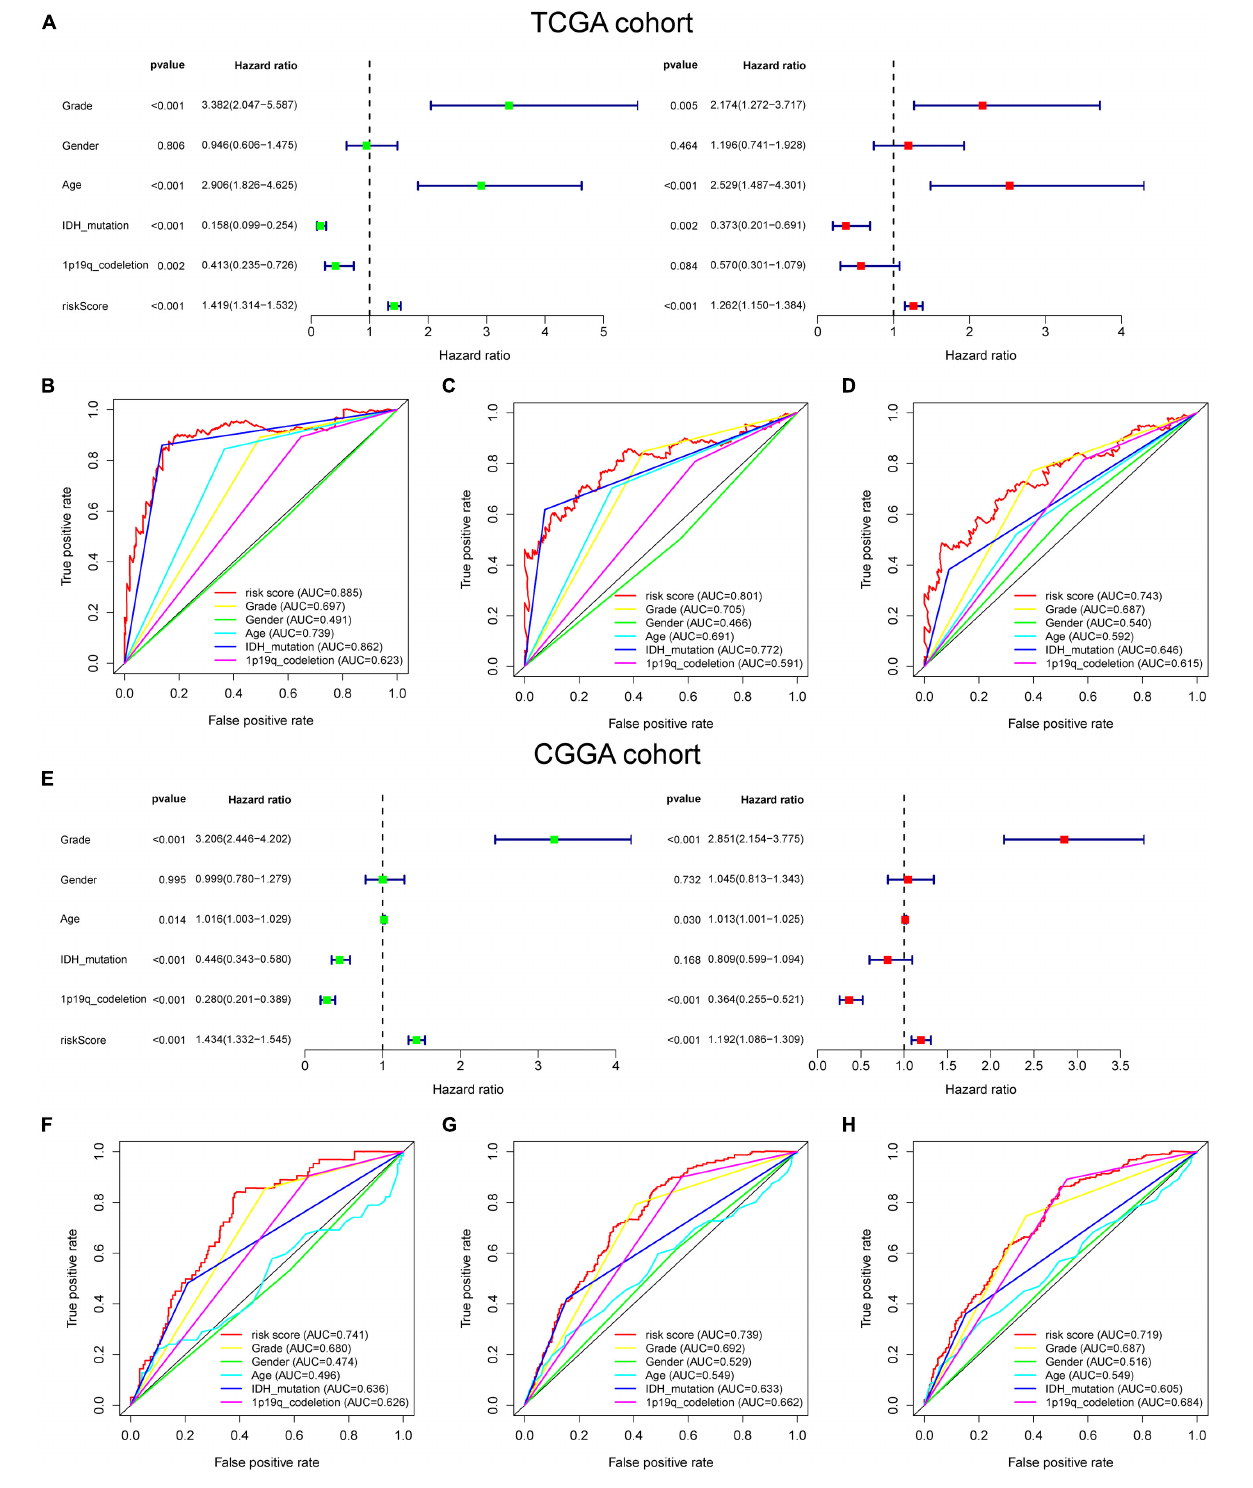
FIGURE 3 | The prognostic value of GSRS. (A) In the training set, forest plot on the left for the univariate Cox test evaluating the association of the risk score and clinical factors with patient OS, and forest plot on the right for the multivariate Cox analysis identifying independent risk factors for the OS of patients. The ROC curve of risk score and clinical factors for predicting 1- (B) , 3- (C) , and 5-year (D) OS. (E) In the validation set, univariate and multivariate COX analysis of risk score and clinical factors. ROC curve of risk score compared with other clinical factors for predicting 1- (F) , 3- (G) , and 5-year (H) OS.